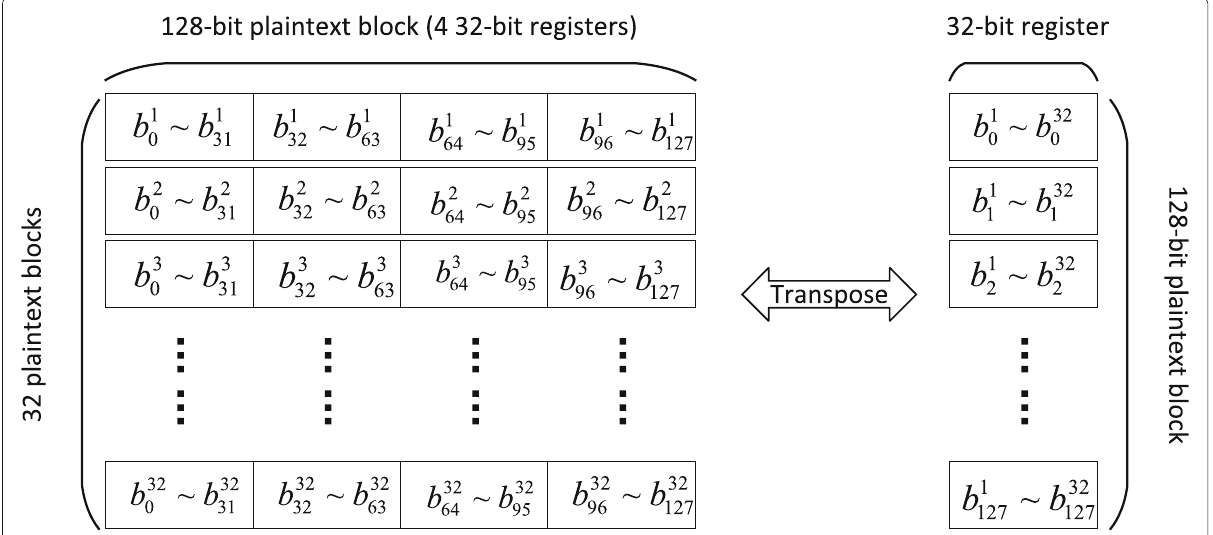
Fig. 1 Transposition in bitsliced AES implementation. On the left side, it shows the normal byte ordering of 32 128-bit plaintext block layout in registers. On the right side, it is the bit-oriented transposed bitsliced ordering layout in registers. The transformation from the left to the right and the reverse are made only once at the beginning of encryption and at the end of encryption,